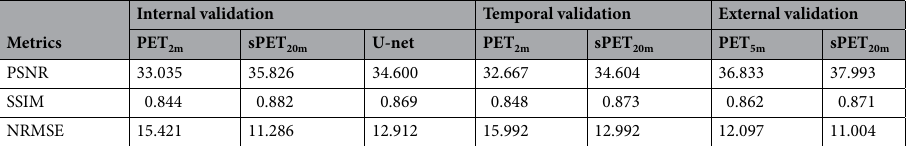
Table 2. Image-quality metrics of PET image categories for internal, temporal, and external validation. NRMSE normalized root mean-square error, PSNR peak signal-to-noise ratio, SSIM structural similarity.